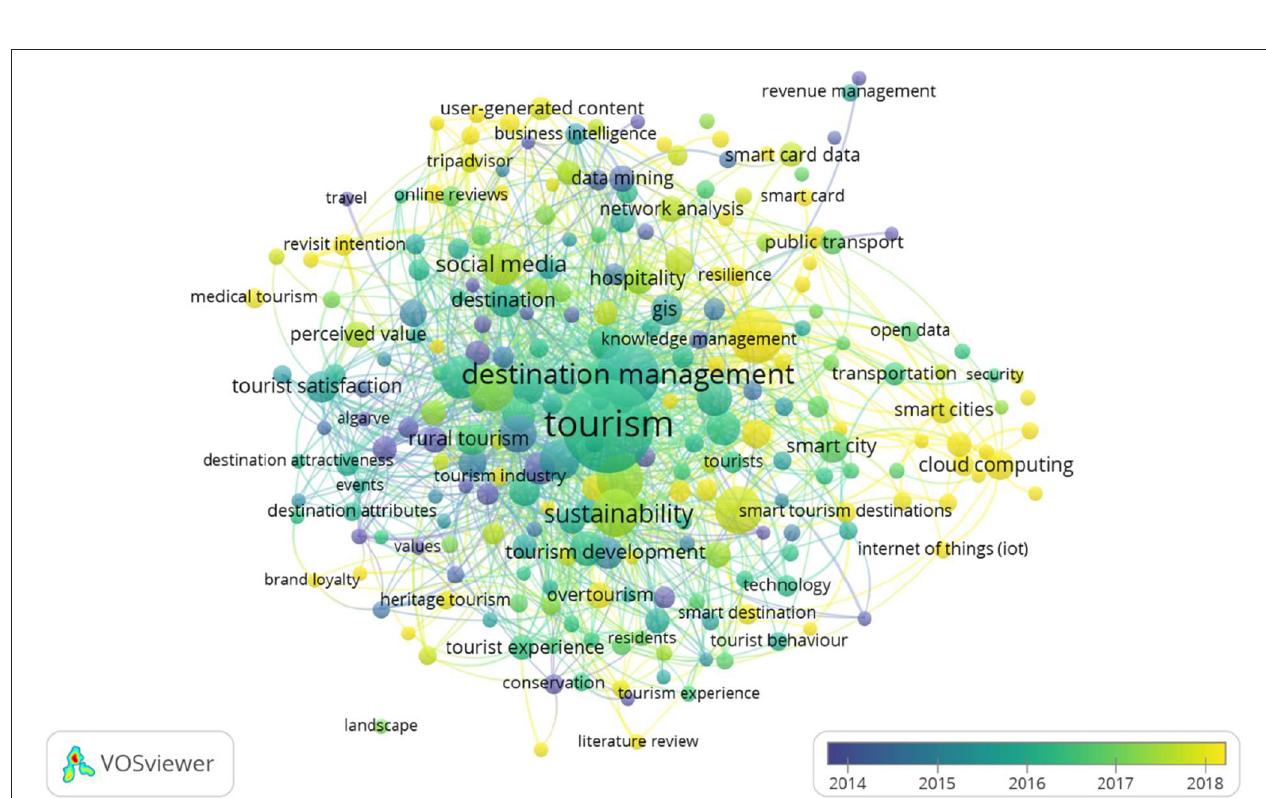
FIGURE 3 | Temporal evolution analysis of author keywords (2015–2021). Source: prepared by the authors using VOSviewer, based on WoS data.